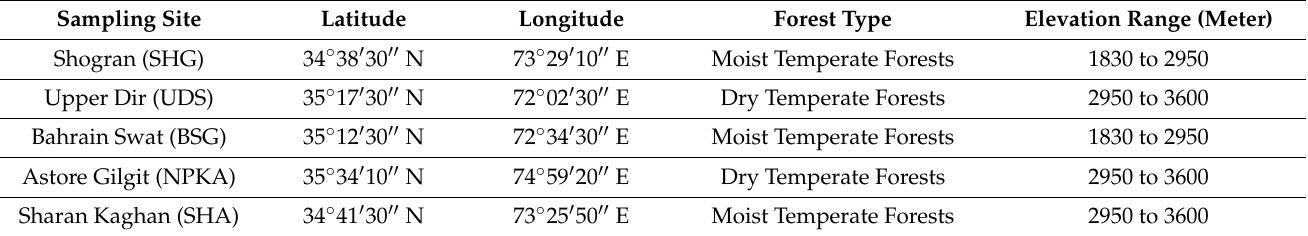
Table 1. Details of sampling sites with elevations of spruce and fir at five sites (SHG, UDS, BSG, NPKA, SHA) during different